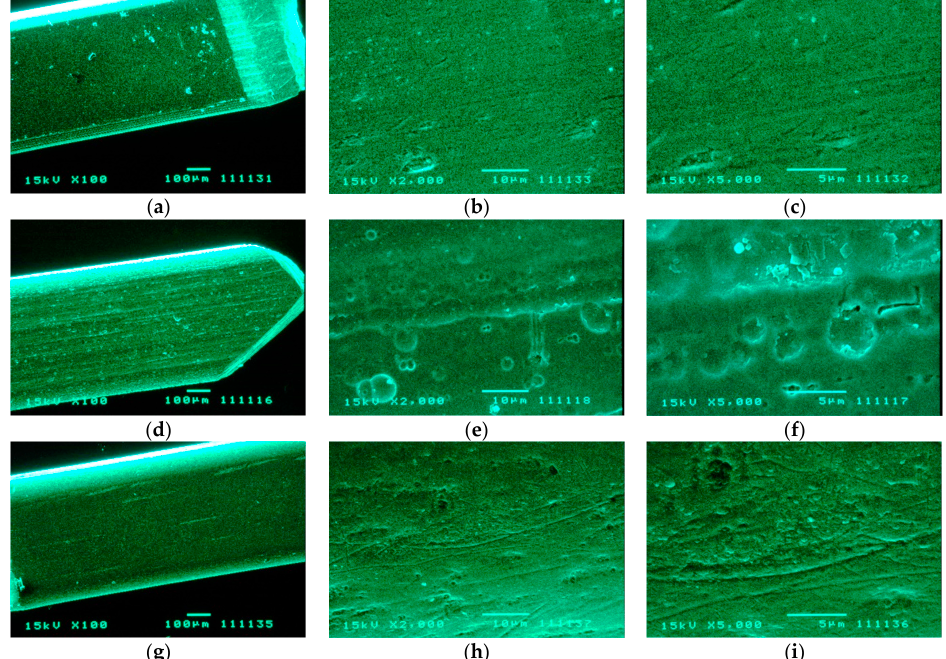
Figure 5. Topographic evaluations of orthodontic appliances by scanning electron microscopy (SEM): ( a ) Stainless steel, ×100; ( b ) stainless steel, ×2000; ( c ) stainless steel, ×5000; ( d ) copper ‐ nickel ‐ titanium, ×100; ( e ) copper ‐ nickel ‐ titanium, ×2000; ( f ) copper ‐ nickel ‐ titanium, ×5000; ( g ) nickel ‐ titanium, ×100; ( h ) nickel ‐ titanium, ×2000; ( i ) nickel ‐ titanium, ×5000. CuNiTi wires ( d – f ) presented more irregularities on the surface with the deepest and largest craters identifying these surfaces with the highest roughness. NiTi arcs ( g – i ) showed topographic alterations slightly lower than CuNiTi samples finding scarce scratches, smaller pores, and cracks resulting in roughness characteristics more acceptable. SS archwires ( a – c ) had scarce irregularities in their topographic resulting in the smoothest surfaces with the lowest values of roughness.